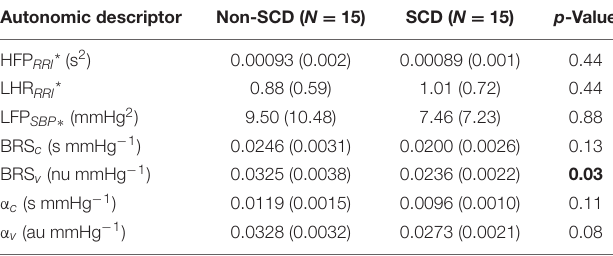
TABLE 3 | Baseline autonomic descriptors.